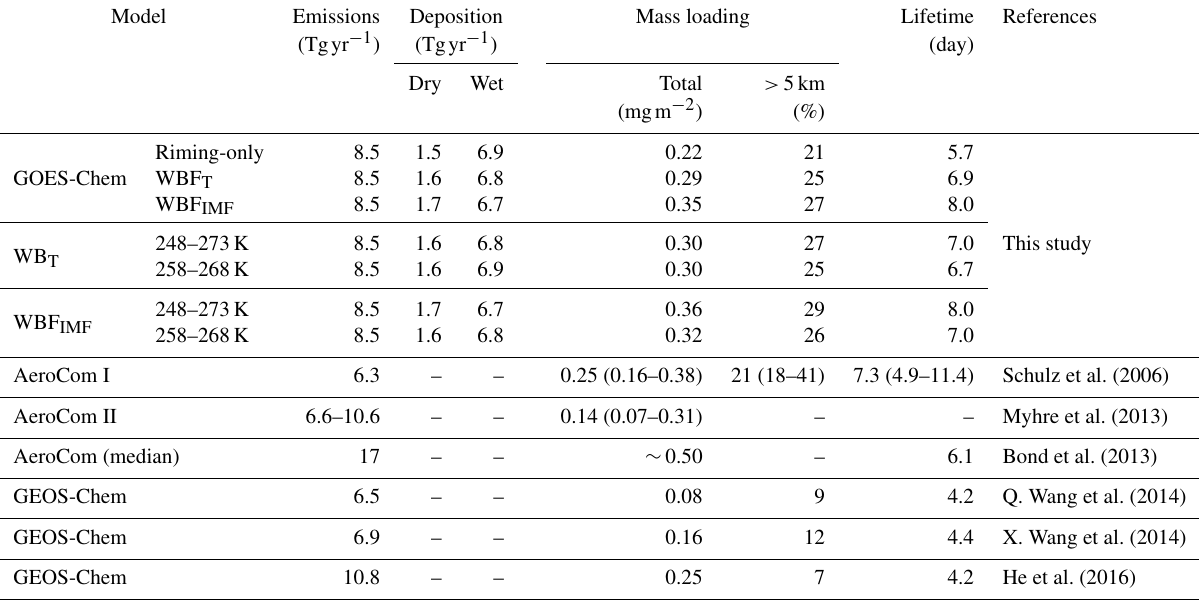
Table 6. Global annual budget of BC. Ranges are given in parentheses.